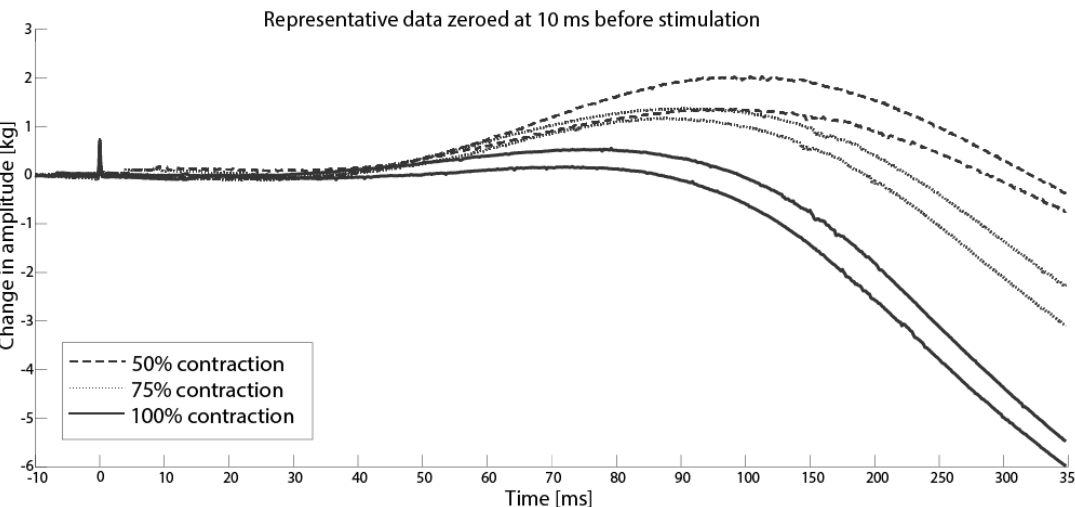
Figure 2. Data from a representative subject of force curves for single trial showing decreasing twitch force with increased voluntary contraction. (Force was zeroed at 10 ms before stimulus).